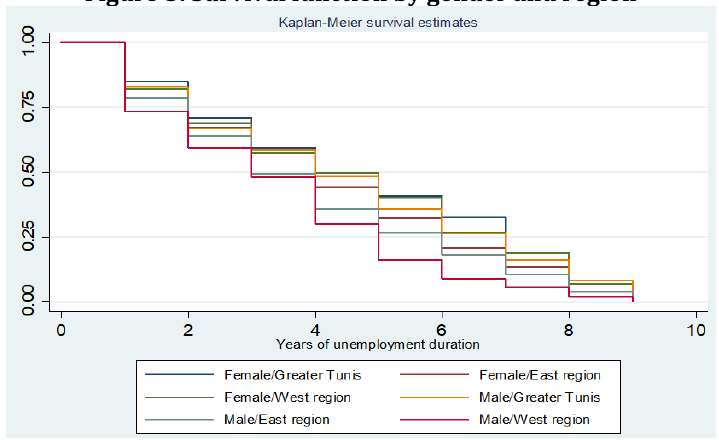
Figure 5: Survival function by gender and